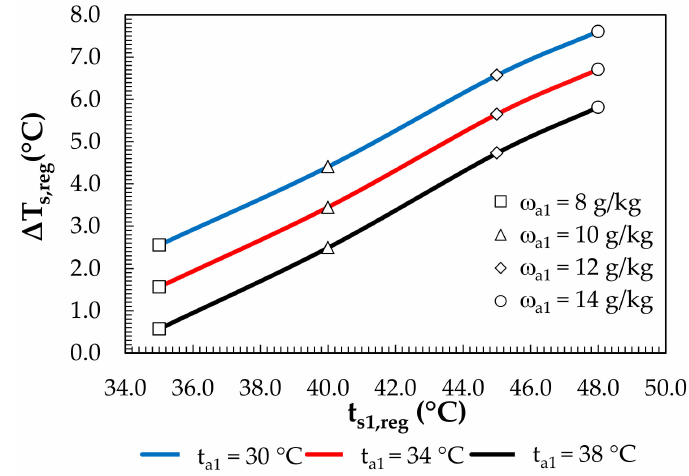
Figure 14. Effects of the solution temperature at the regenerator inlet and regeneration air parameters on the solution temperature drop.